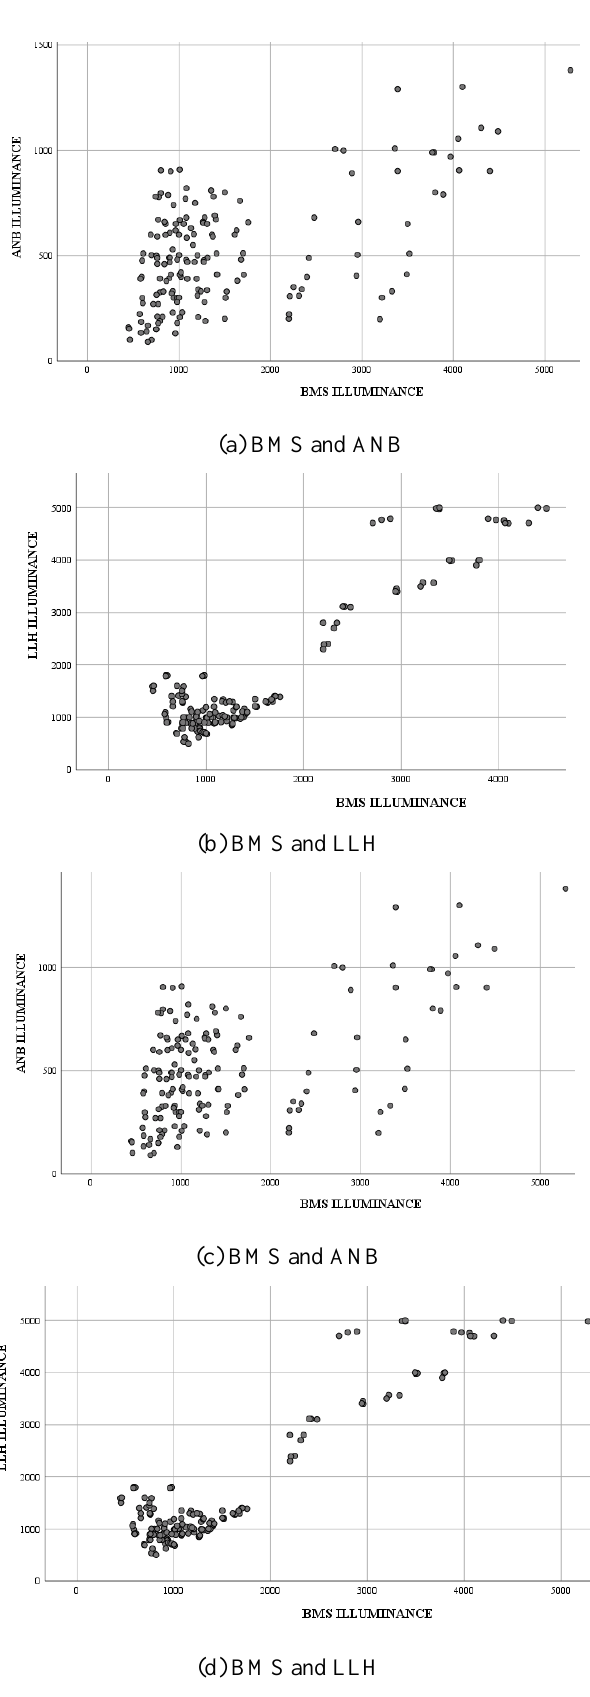
Fig. 7. Scatter plot showing illuminance distribution relationship between